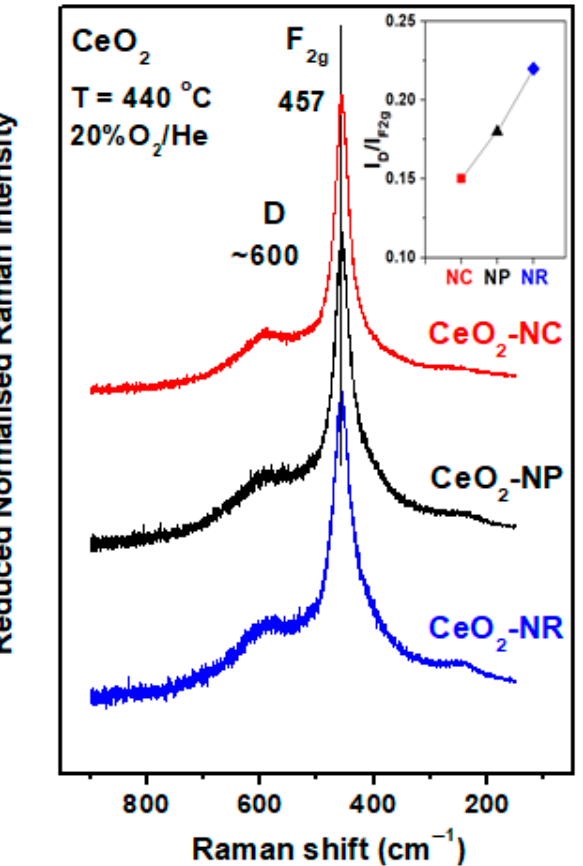
Figure 5. In situ Raman spectra for different ceria nanoshapes, i.e., NR, NP and NC. Inset depicts the I D /I F2g intensity ratio. Laser power, w = 25 mW; laser wavelength, λ 0 = 491.5 nm; spectral slit width, 6 cm − 1 . Adapted from Reference [34]. Copyright© 2018, Elsevier. Table 3. Surface properties of ceria nanoparticles.